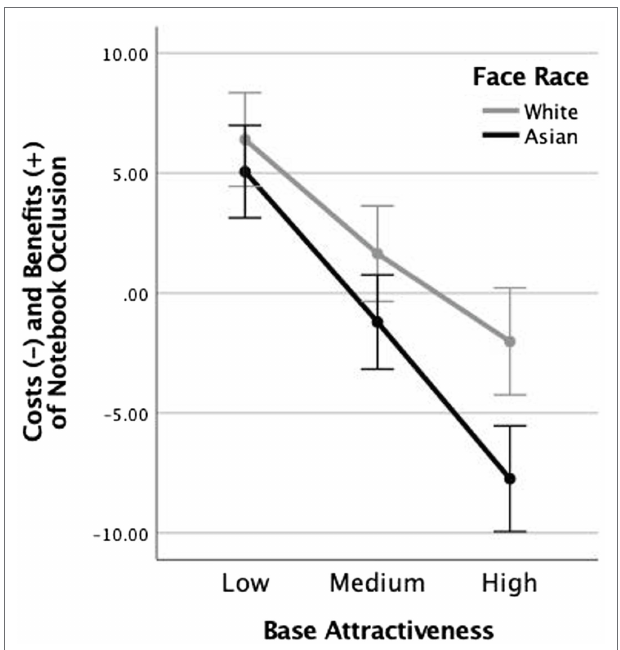
FIGURE 4 | Notebook occlusion cost and benefit score, computed as the difference between attractiveness ratings for faces occluded with a notebook and those not occluded by anything, for White and Asian faces. Error bars represent +/ − 1 standard error.